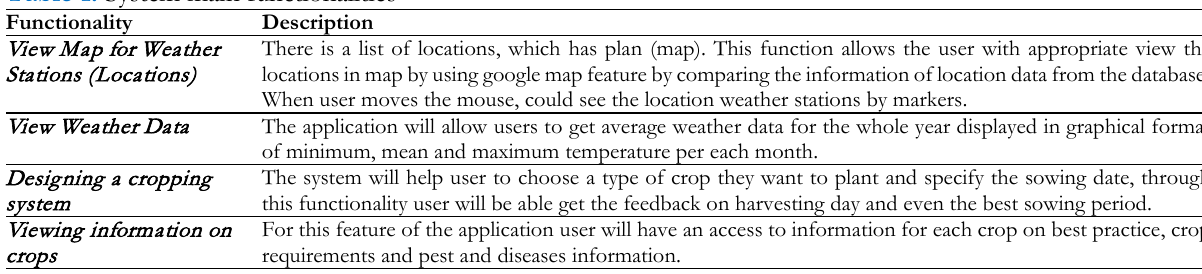
Table 1. System main functionalities Functionality Description View Map for Weather Stations